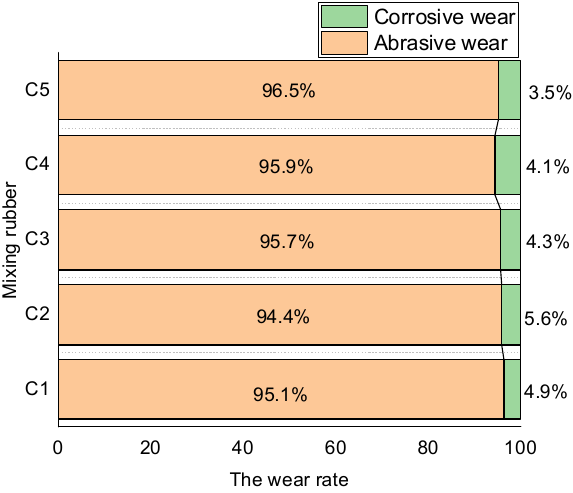
Figure 15. The ratio of the two wear mechanisms. Figure 14. Metal wear volume without spraying the ethanol–water mixture.